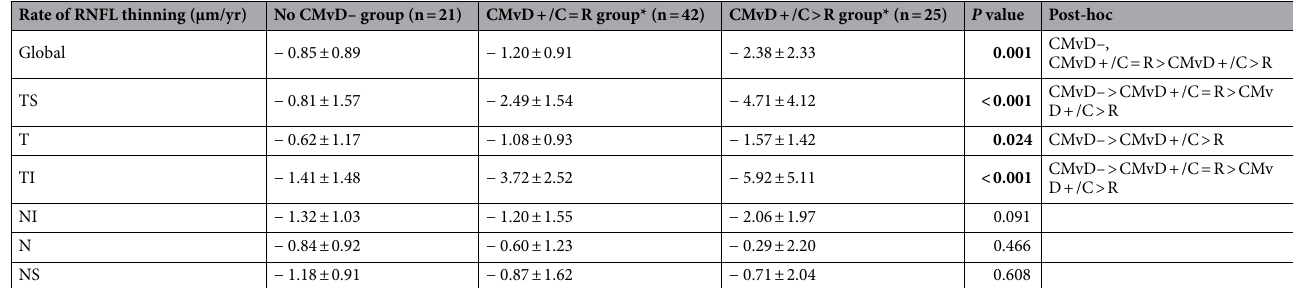
Table 3. Comparison of rate of circumpapillary retinal nerve fiber layer thinning per year among groups. Values area mean ± standard deviation. Values with statistical significance are shown in bold. Comparison was performed using 1-way analysis of variance with post hoc Sidak multiple comparison testing. Values that were significant are shown in bold. RNFL retinal nerve fiber layer, CMvD choroidal microvascular dropout, TS temporo-superior, T temporal, TI temporo-inferior, NI naso-inferior, I inferior, NS naso-superior. *Ratio of the circumferential width of CMvD to that of the RMvI, between 0.75 and 1.25, and > 1.25 were defined as CMvD + /C = R and CMvD + /C > R,